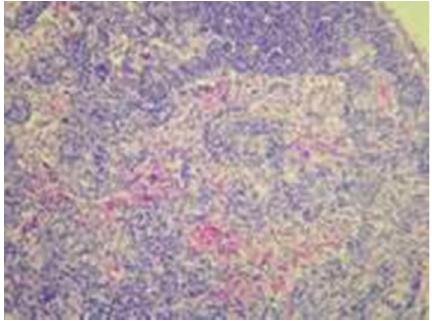
Figure 2: Model control group: 12 hours in SAP rat expansion of lymph sinuses, hyperplasia of sinus cells, and obvious infiltration of many inflammatory cells, HE × 200.